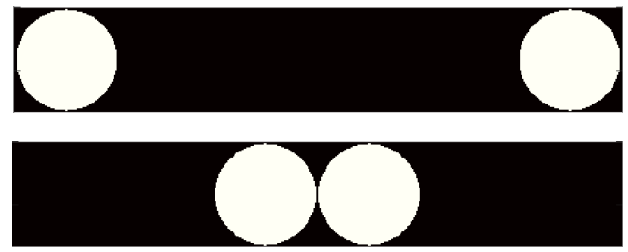
Figure 4: Normalized current distribution at 𝜁 = 0.05 .